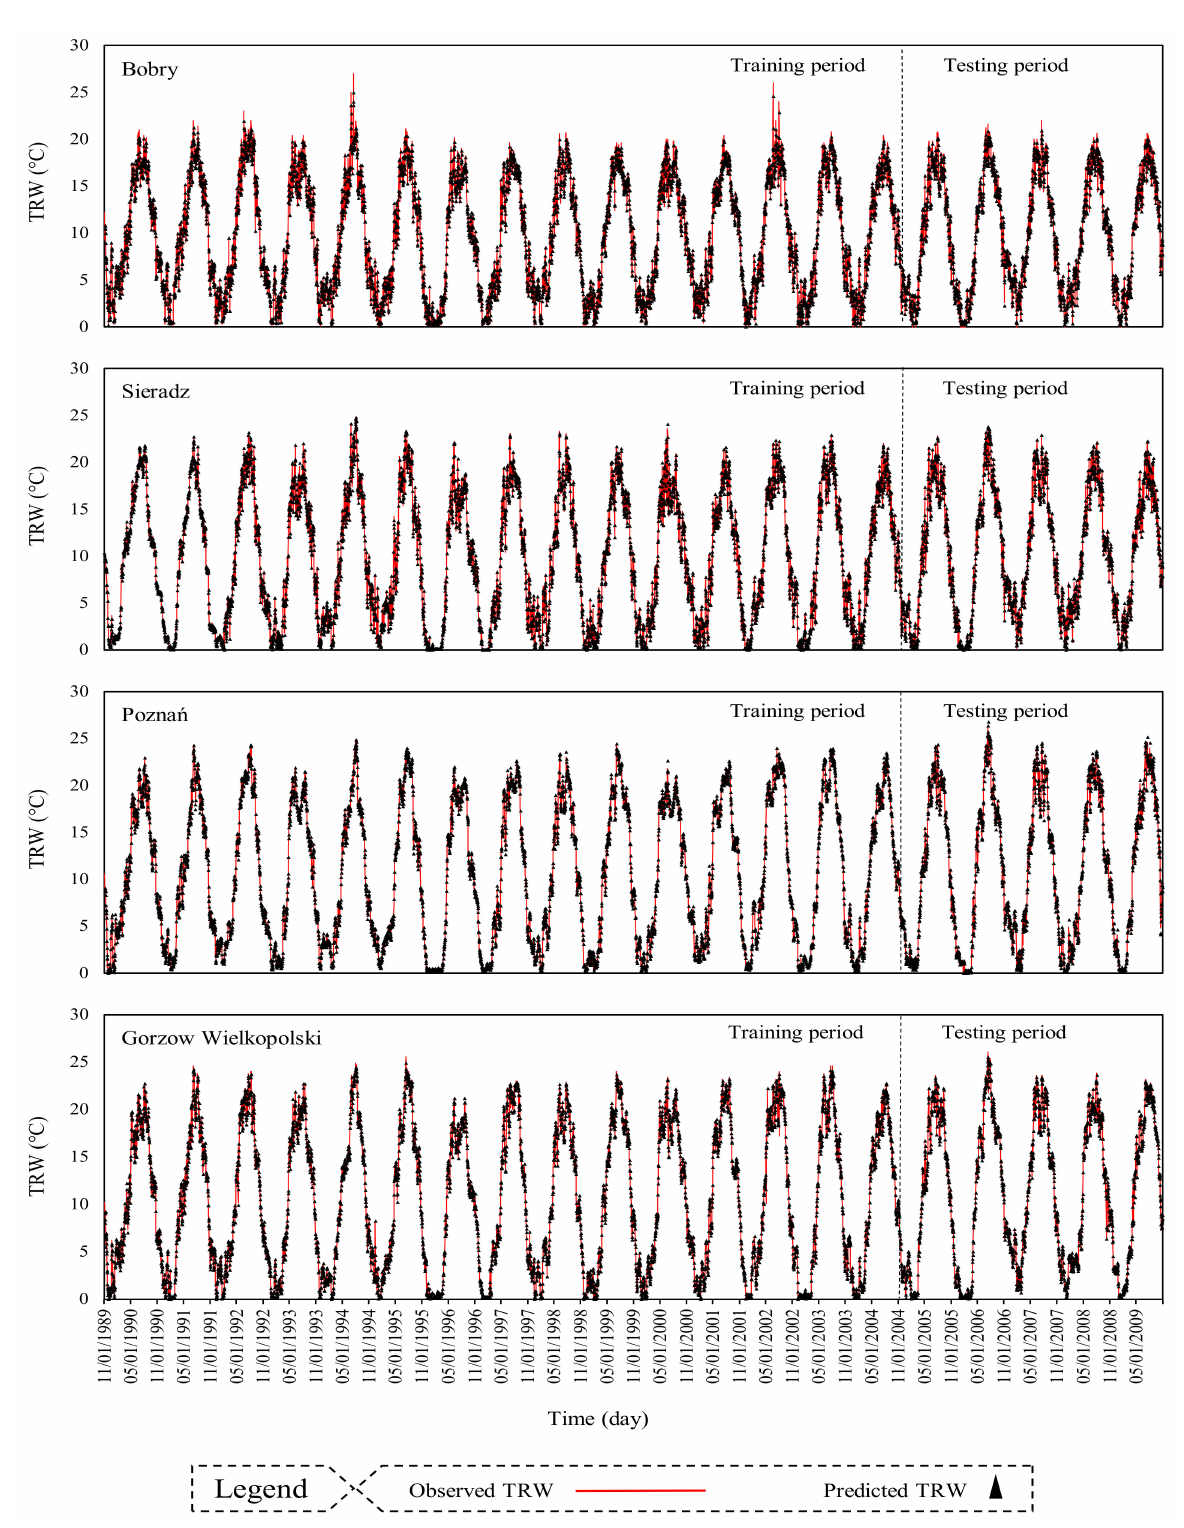
Figure 10. Time series plots of the best predicted outputs of each station, beside its observed TRW. Research on the trend of changes in TRW in Poland, carried out by Graf and Wrze- si´nski [80], identified water gauges on the Warta River in which the observation series